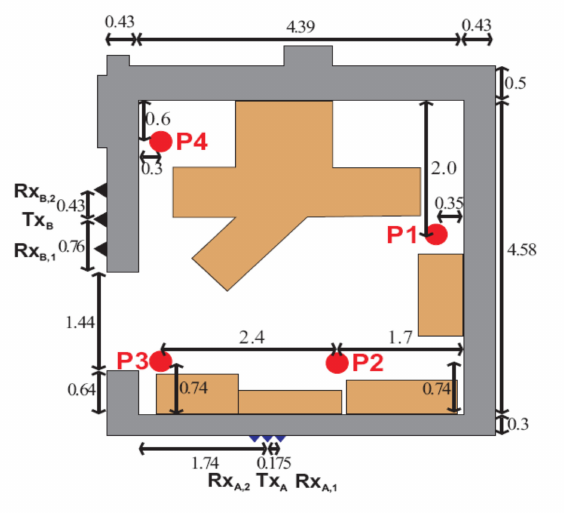
Figure 1. Deployment of radar systems and movement of the target in the